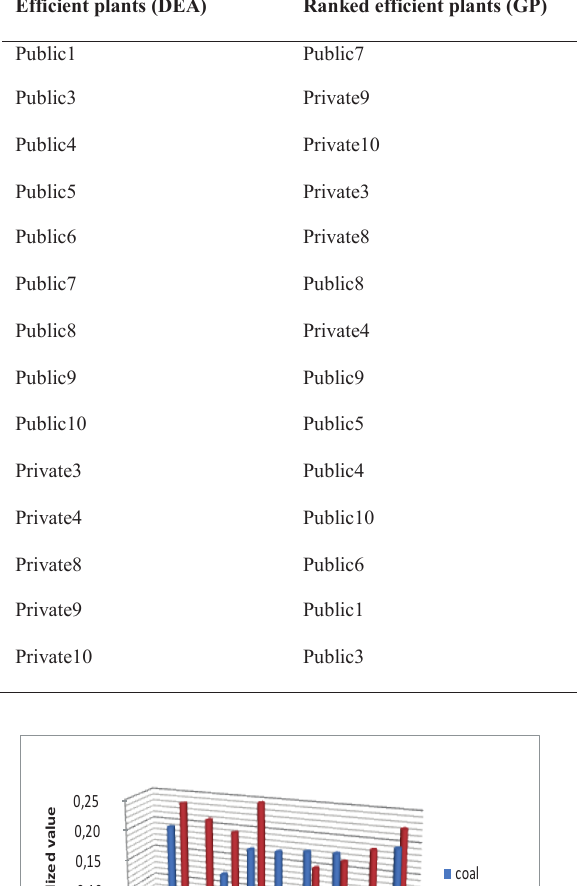
Table 8. Ranking of power plants according to the investment efficiency